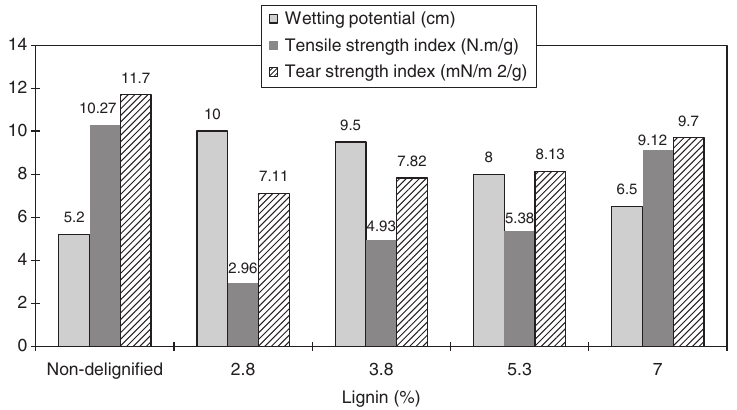
Figure 2: Influence of OCC fiber characteristics on the wetting potential, tensile strength index, and tear strength index.